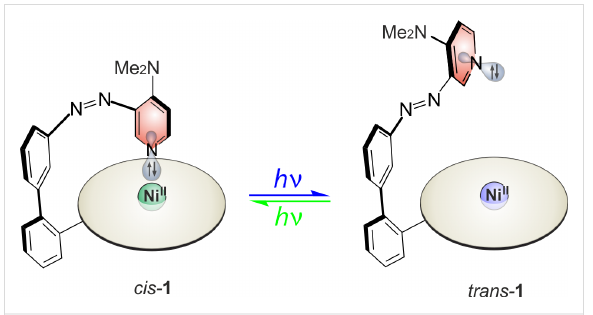
Figure 1: Basicity and nucleophilicity switching of the 4-( N,N -dimethyl- amino)pyridine “record player” molecule 1